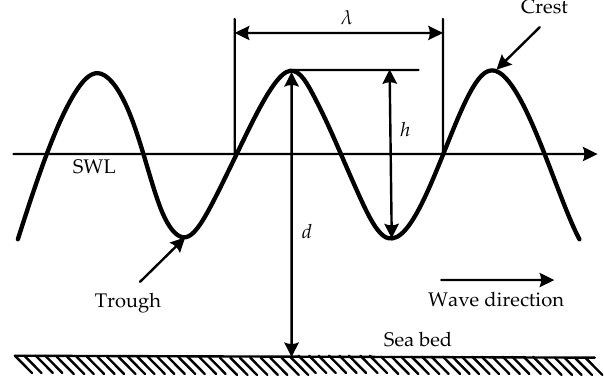
Figure 2. Ocean wave.